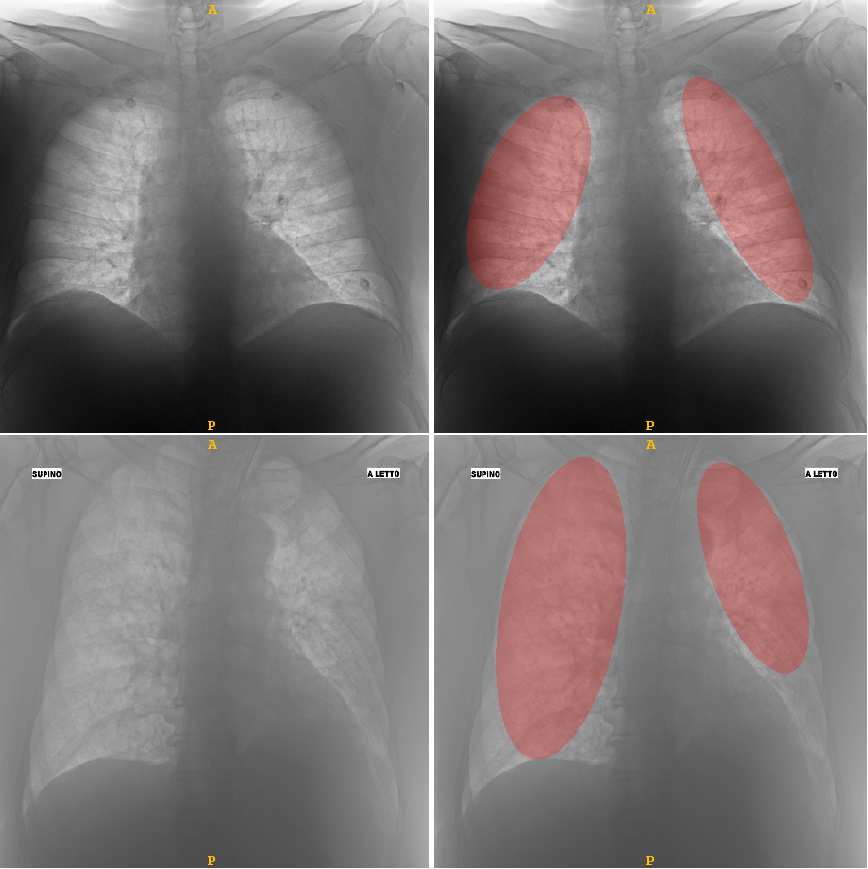
Figure 1. Two examples of segmentation obtained by means of the semi-automatic tool able to assist clinician to detect the elliptical ROIs (highlighted in red) within lungs: in the upper row a MILD sample; in the lower row a SEVERE